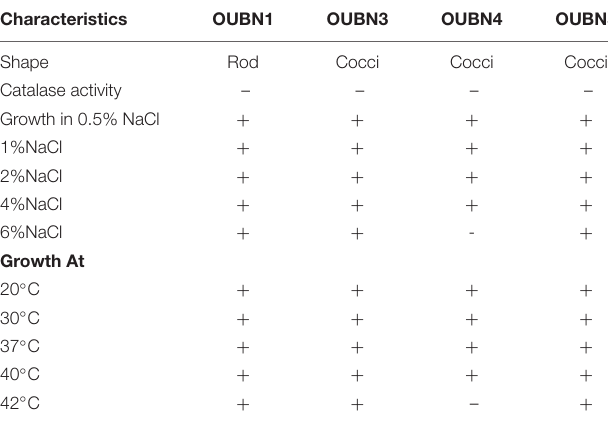
TABLE 3 | Morphological, biochemical, and physiological characteristics of the LAB Isolates from Toddy palm